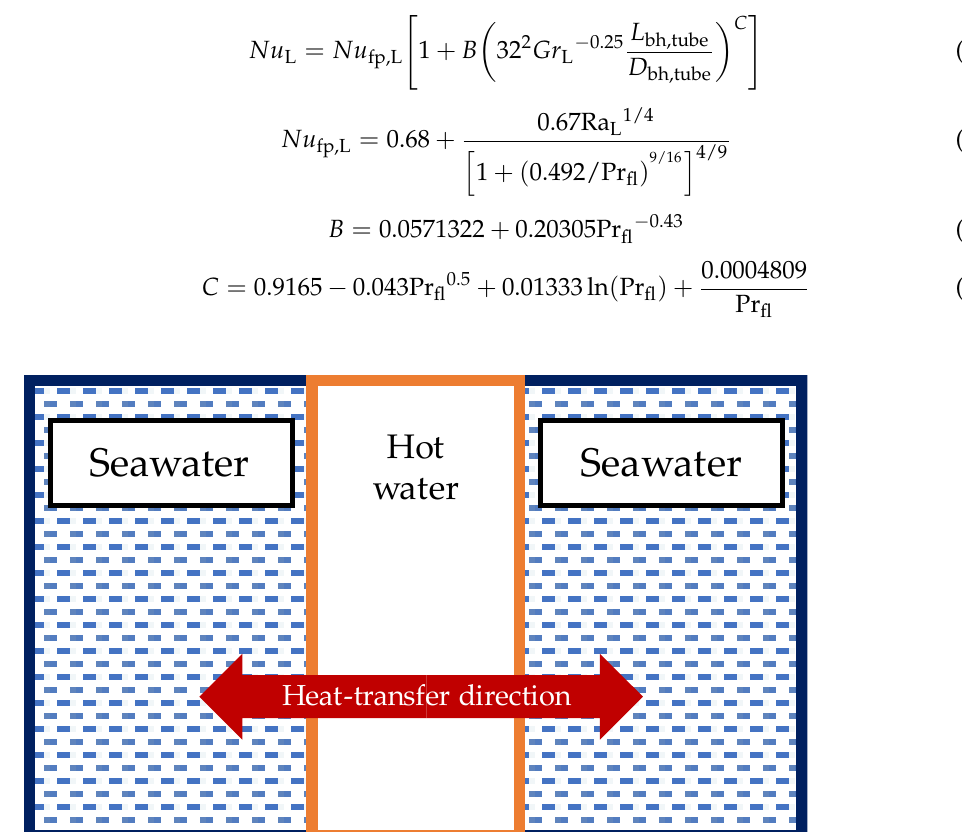
Figure 12. Heat-transfer interaction for the vertical bundle heater.